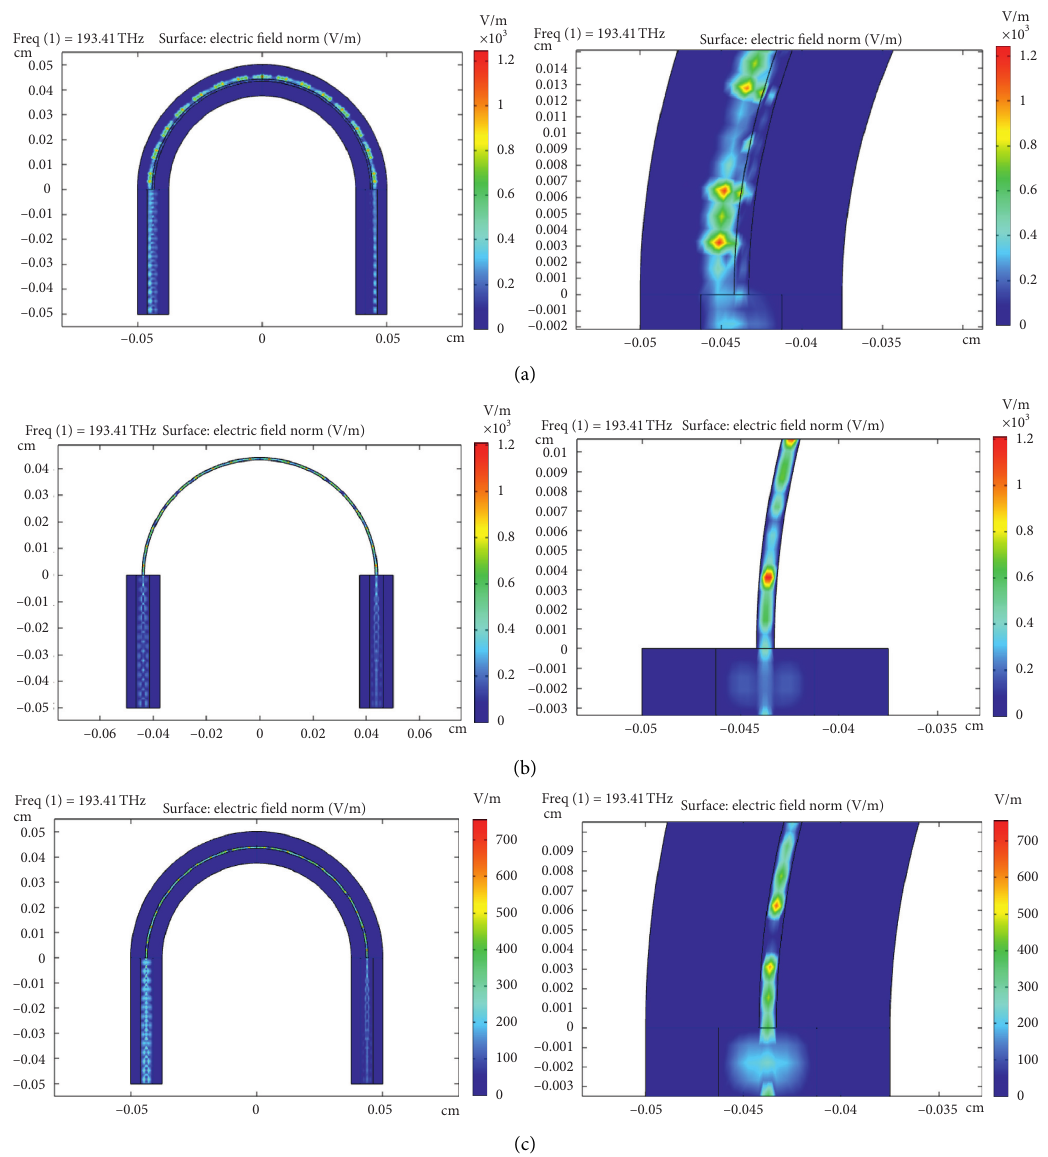
Figure 2: The electric field propagating along the macrobend heterocore of fiber optic when the refractive index of cladding is � 1.4612, (b) n � 1, and (c) n � (a) n silica air ZnO Figure 6. To determine the optimum fiber geometry, the propagating light is then simulated as a function of ZnO film thickness. The result is shown in Figure 7. A low loss starting from 5.0 μ m exists, and the loss increases at the smallest thickness of the ZnO film because the evanescent wave extends into the cladding region. The effect of introducing additional second cladding is significant in terms of reducing optical propagation losses without an etching process by using a chemical reagent or a costly process. ZnO has a more significant effect in reducing the loss because the refractive index difference is larger compared with that in a silica fiber.